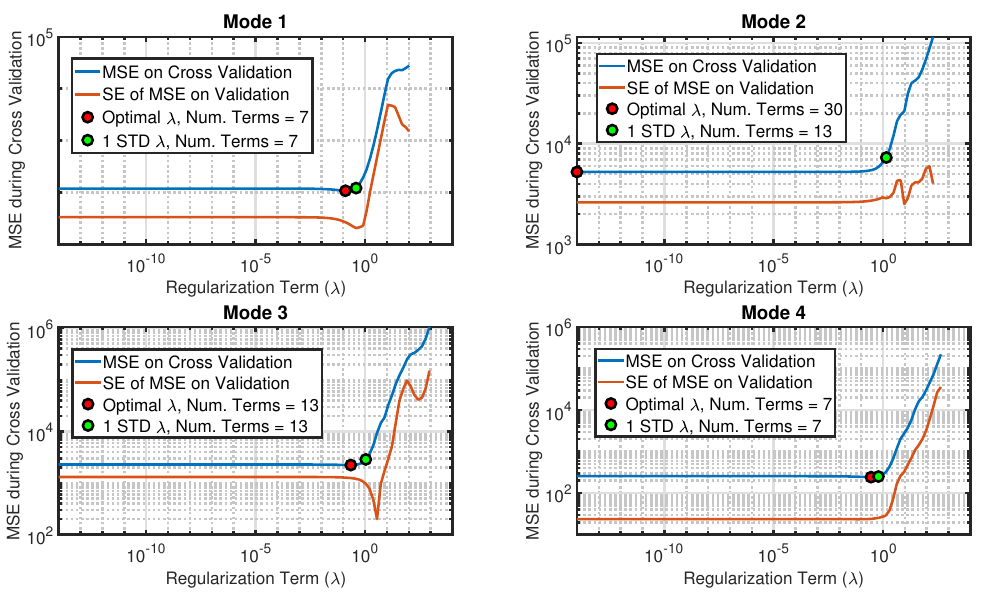
Figure 8. Mean squared error (MSE) and standard error (SE) of k-fold cross validation for each λ value.